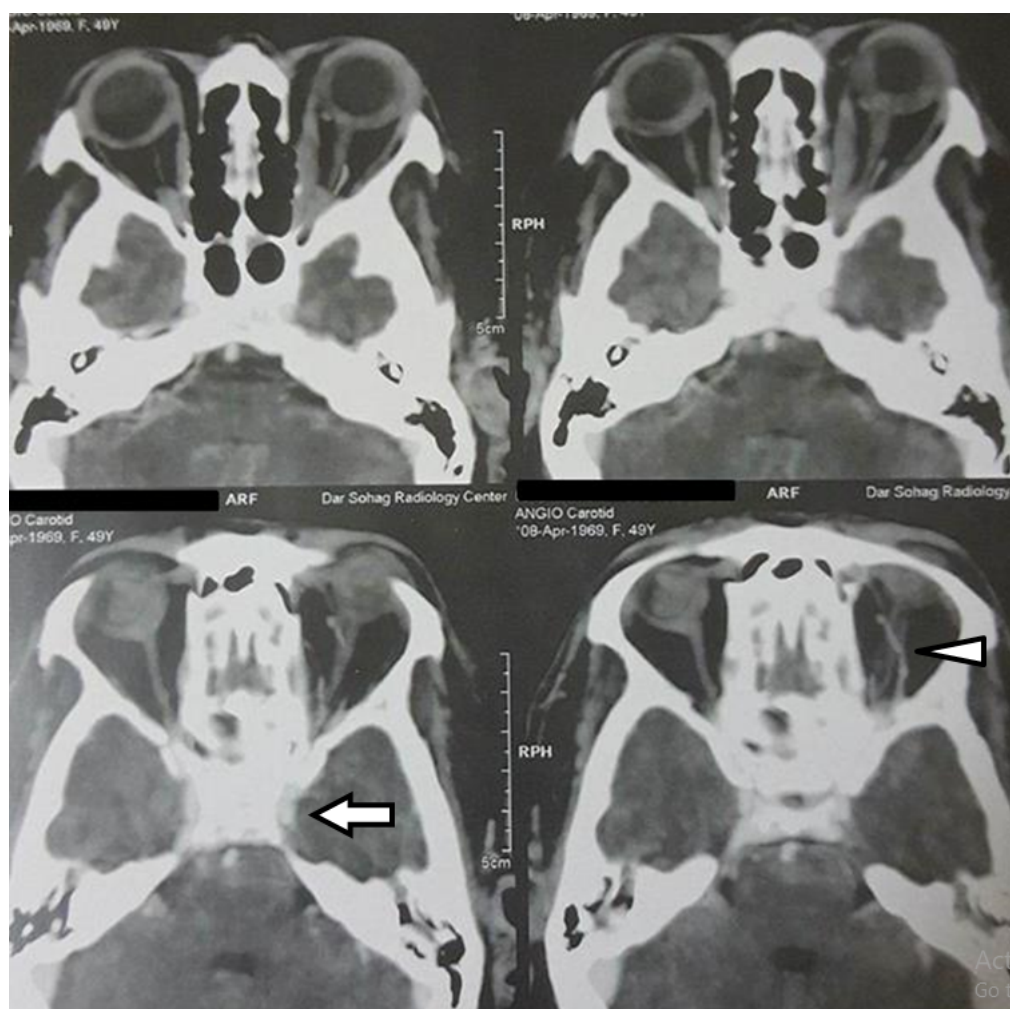
Figure 2: Minute small vessels around the early opacified left cavernous sinus (arrow) with dilated superior ophthalmic vein (arrow